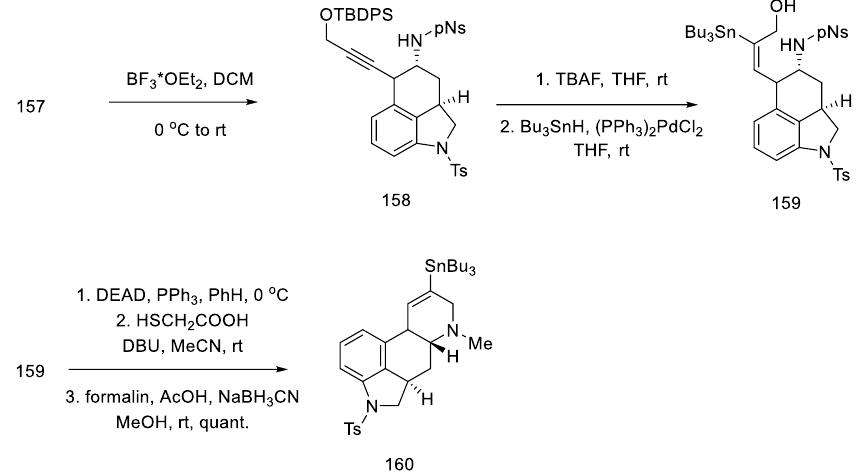
Scheme 61. Synthesis of aziridine 157 in the Mitsunobu